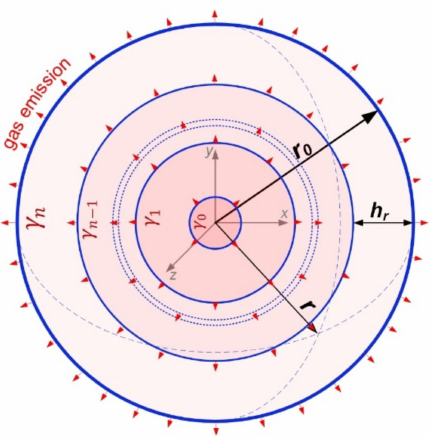
Figure 2. Scheme of the spherical grain division adopted for the calculation of gas density changes within its individual parts during gas emission.